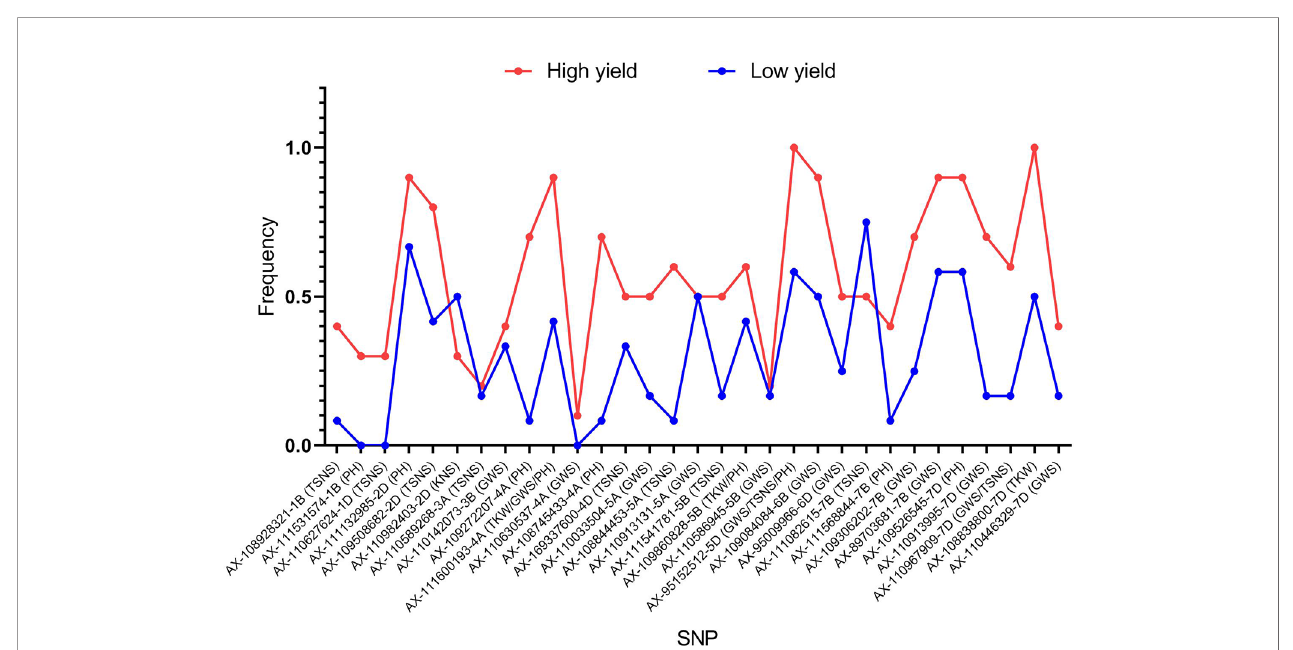
FIGURE 8 | Frequencies of favorable alleles in the high yield accessions and the low yield accessions across all 31